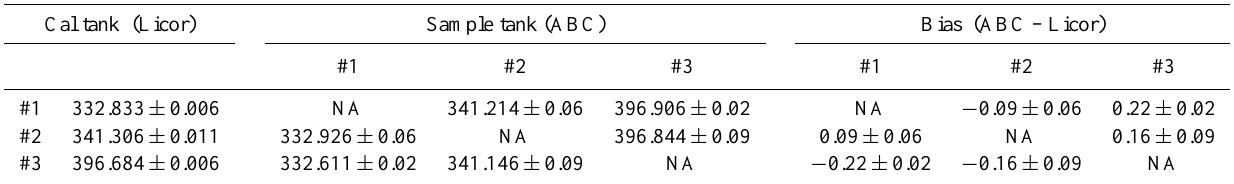
Table 2. ABC-prototype accuracy performance. All reported values are for the major CO 2 isotopologue 626, in units of ppm. Errors are 1 standard deviation from repeated